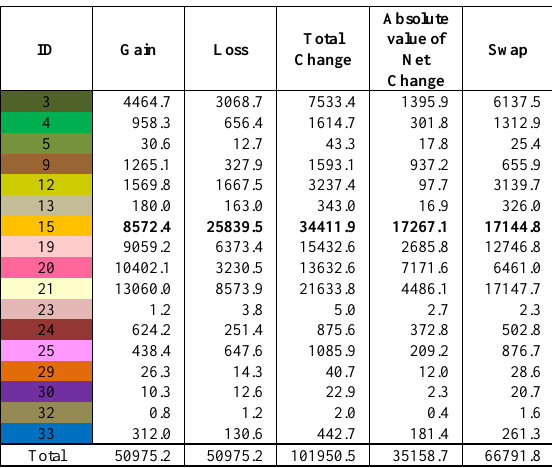
Table 3. Land cover changes in terms of area (km 2 ) for each category. Bold numbers highlight the pasture land